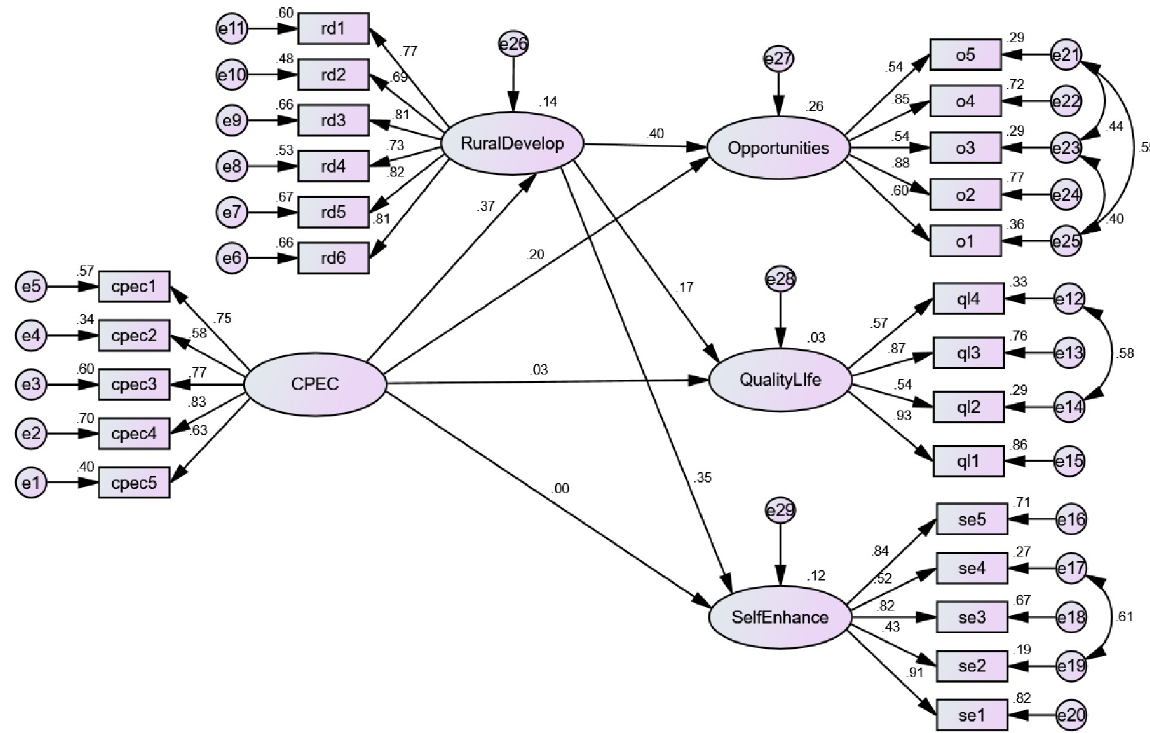
Fig 7. Structural model estimation.